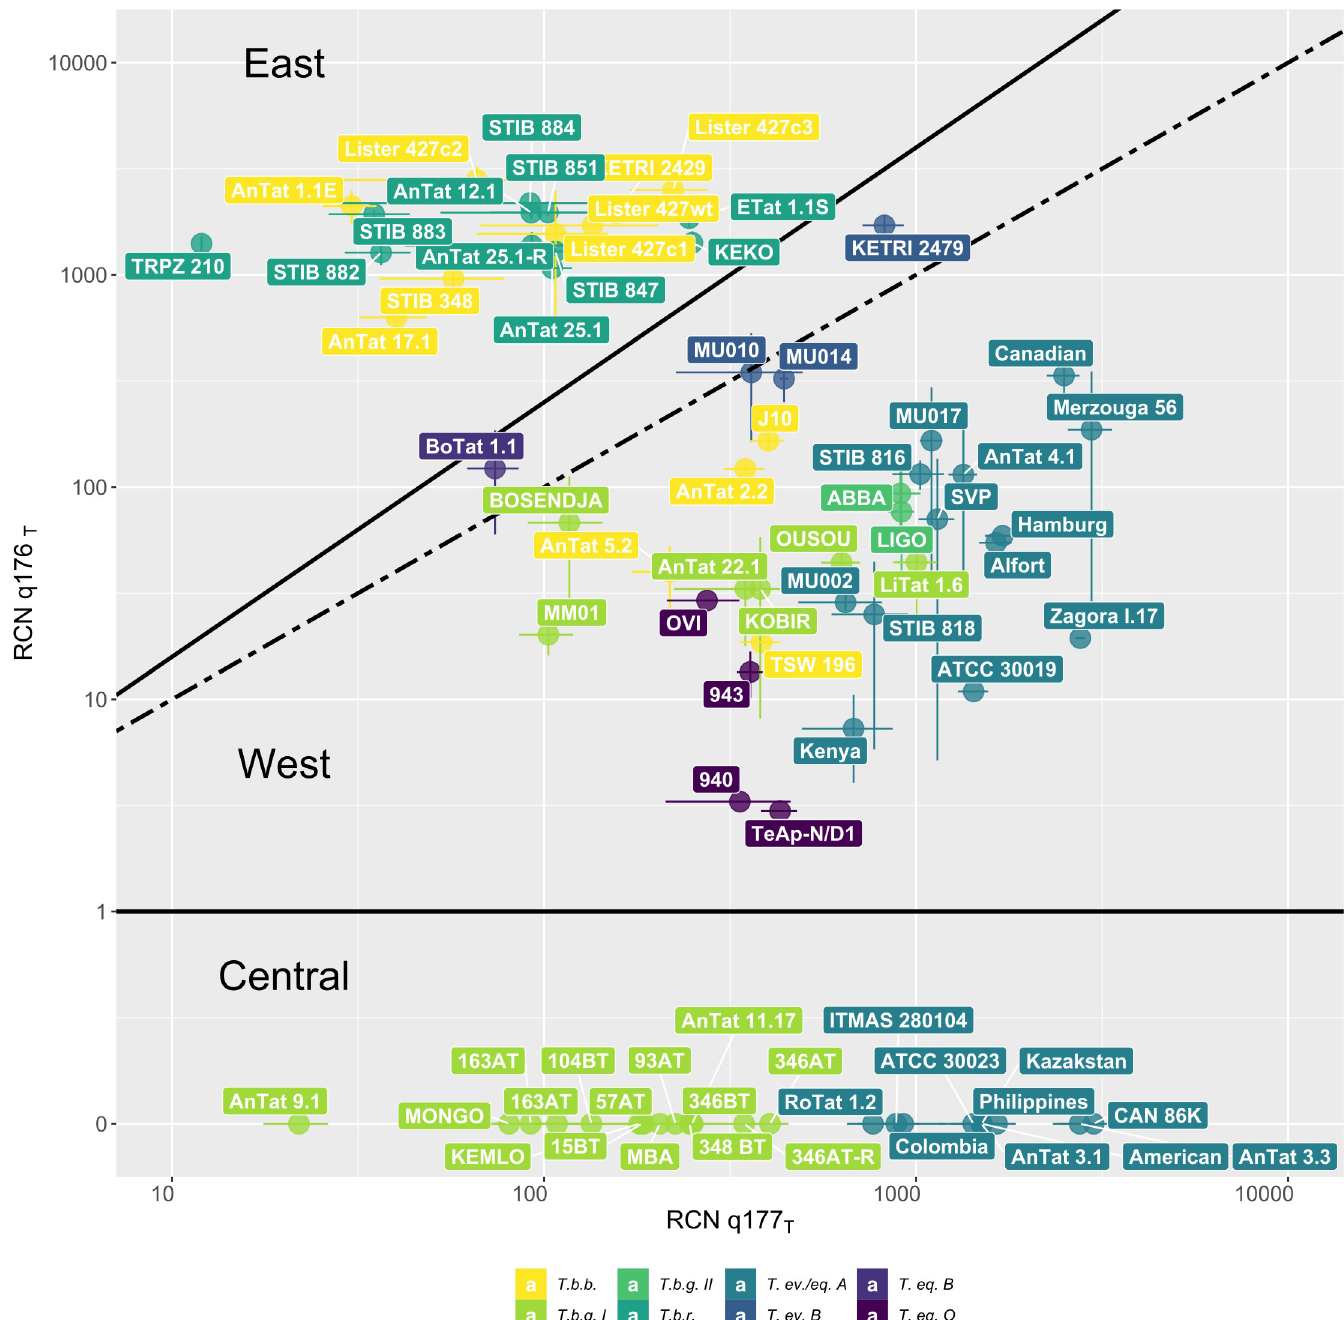
Fig 4. Three TBR genotypes among 77 Trypanozoon strains. All Trypanozoon stocks were tested at 50 ng of pure genomic DNA using the qTBR. Mean and standard deviation were calculated using three replicates for each sample. RCNs for target sequences q177 T and q176 T were calculated using the Δ C q -method with q18S as reference and plotted in a scatterplot. Two solid lines were drawn to divide the Trypanozoon strains into roughly 3 TBR-genotypes: East, West and Central. The line at y = 1 separates TBR-Central from both TBR-West and TBR-East, while the line at y = 1.2x separates TBR-East from TBR-West and TBR-Central. The dotted line at y = x represents equal RCNs for q177 T and q176 T